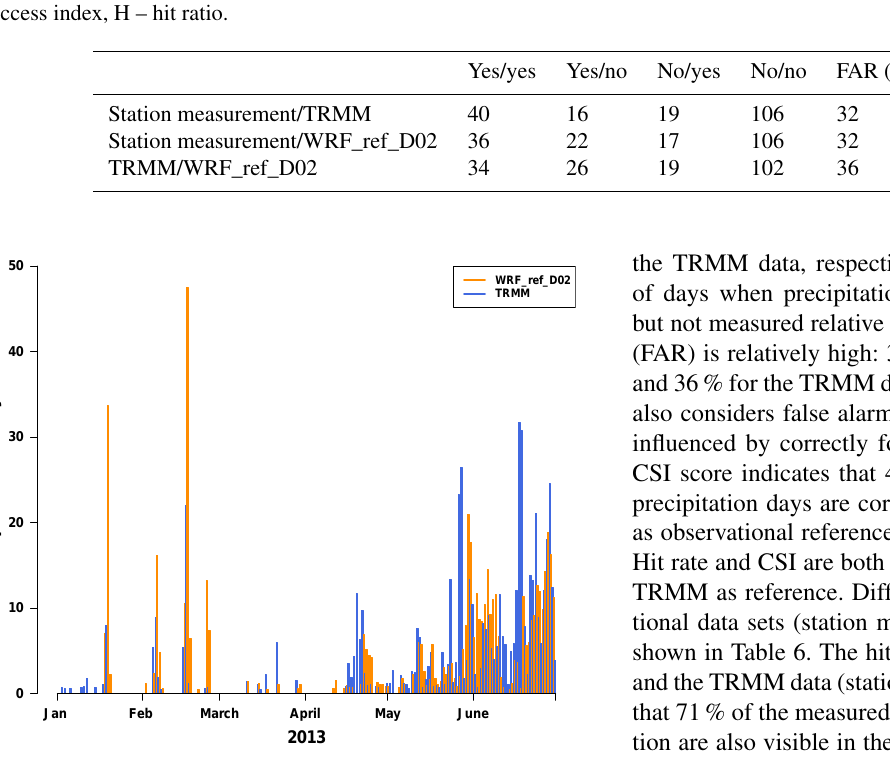
Figure 10. Time series of precipitation (mmday − 1 ) averaged over the domain D02 from WRF_ref_D02 and TRMM per day for January–June 2013 based on daily